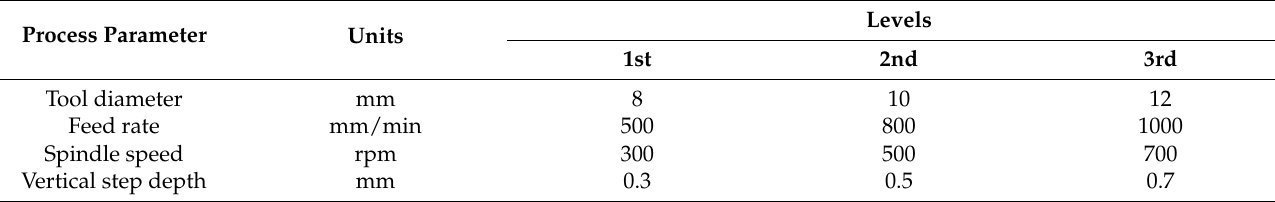
Figure 1. Experimental setup of ISF with the heating system. Table 2. Parameters and their levels.